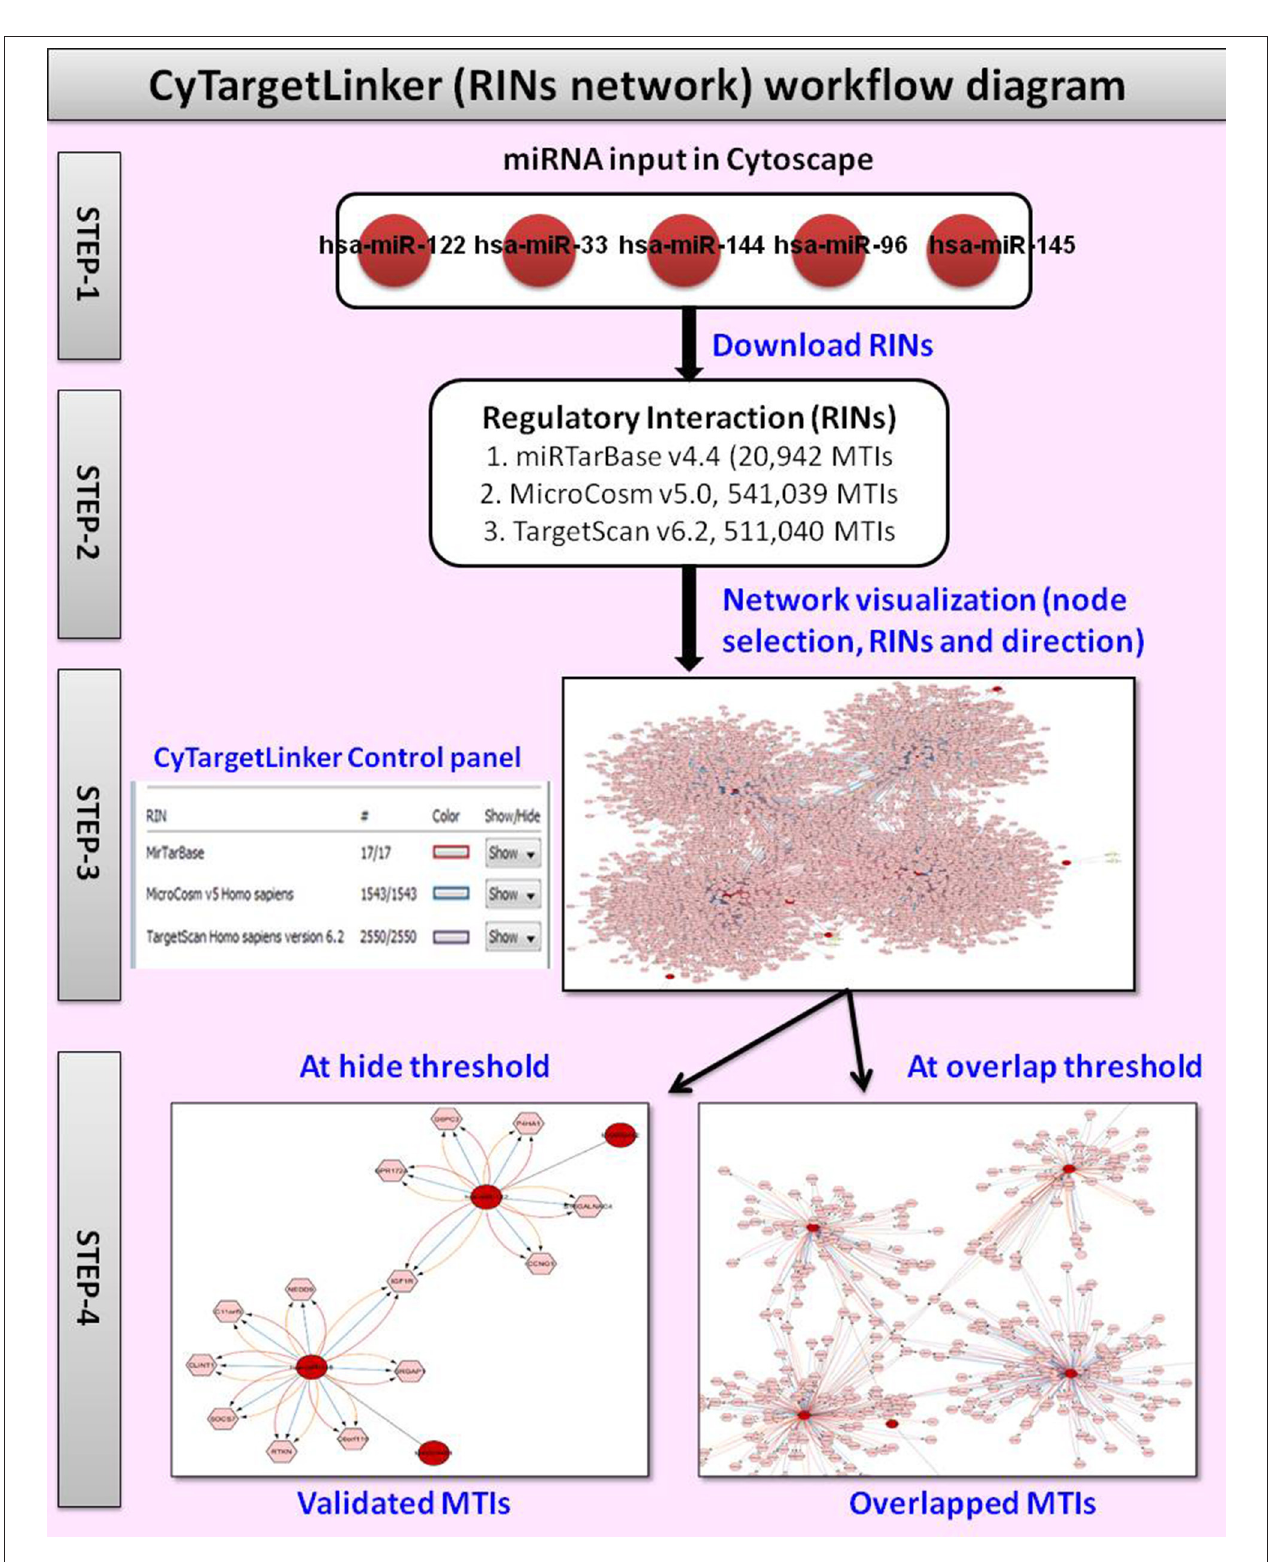
FIGURE 3 | Workflow diagram of CyTargetLinker regulatory interaction